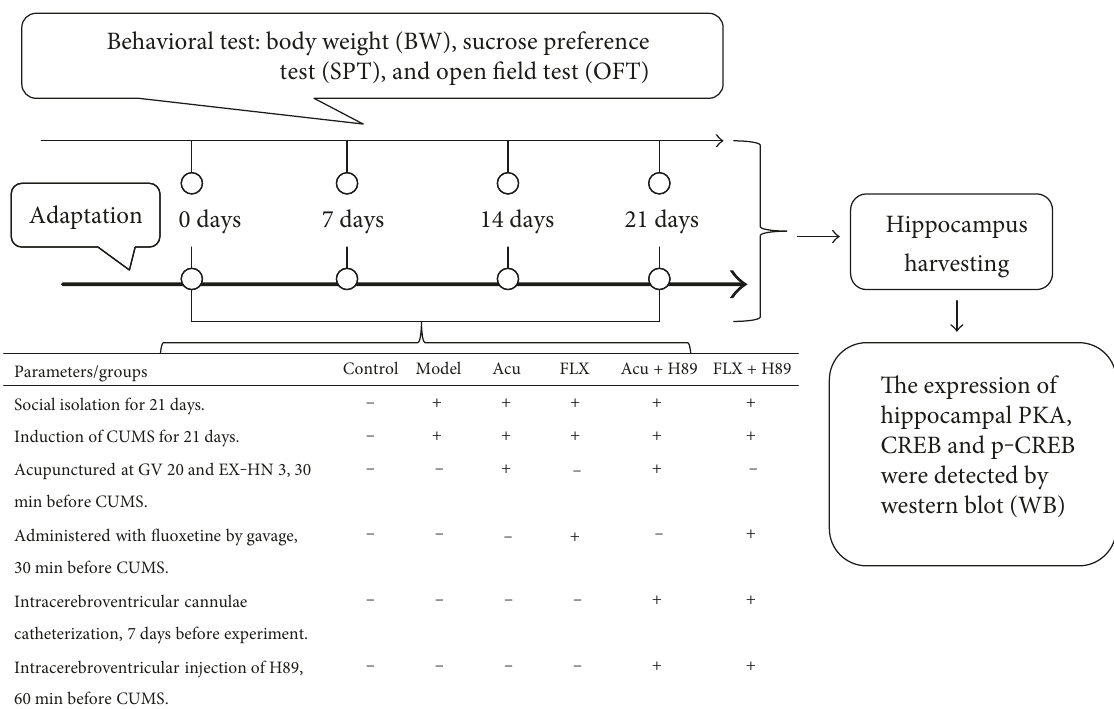
Administered with fluoxetine by gavage, 30 min before CUMS.